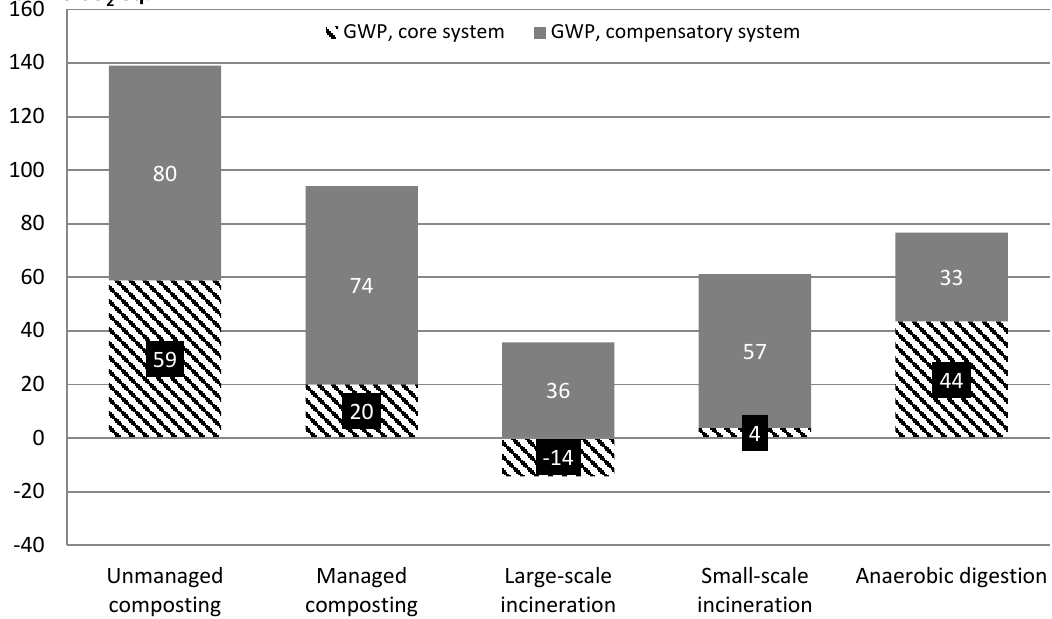
Figure 6. GWP in simulated sensitivity analysis.